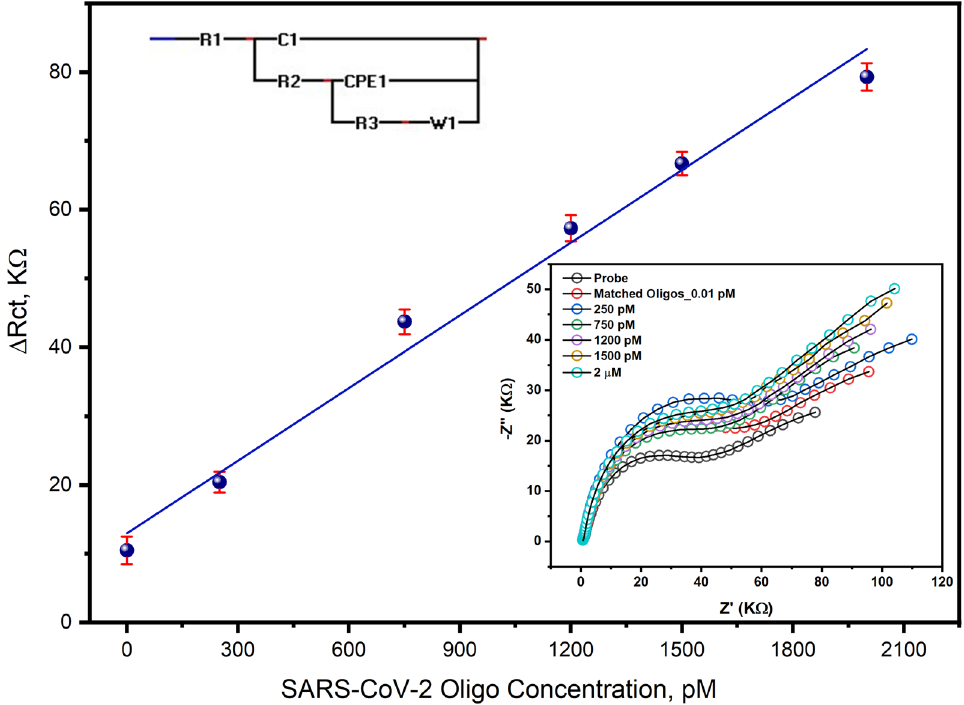
Figure 5. Standard calibration curve of the SARS-CoV-2 RNA biosensor using different concentrations of the virus signature nucleotide sequence ranging from 10 fM to 2 µM. In FCN mediating Tris buffer, the impedimetric signals were investigated before and after the hybridization with the different concentrations of the matched oligos for three individual readings. ΔR ct values determined after fitting the resulted signals using the Randles cell circuit where R1: FCN/TE buffer resistance, C1: capacitance of sensor surface, R2: resistance of immobilized probe, CPE1: constant phase elements of polymerized amino thiophenol monolayer, R3: the resistance of the hybridized matched oligo, and W1: Warburg impedance for the FCN diffusion on the electrode surface. The LOD and LOQ were 298.1 and 993.7 fM, respectively. The obtained R2 from the linear regression was 0.99 and P -value was <